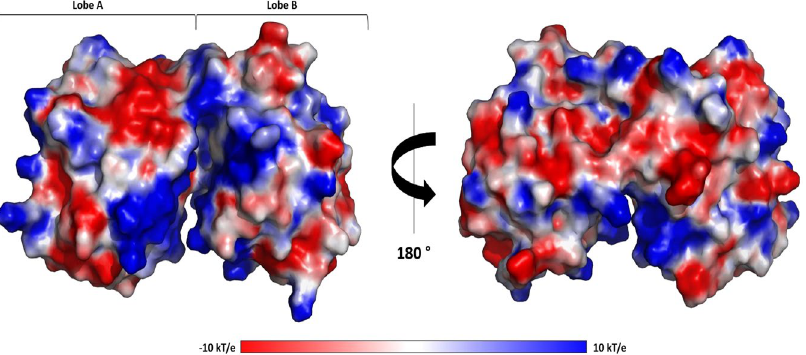
Figure 6. Electrostatic potentials of TupA surface. Electrostatic surface potentials were calculated using Pymol 50 . Surface potentials varies from − 10.0 kT/e (red) to 10 kT.0 kT/e (blue).